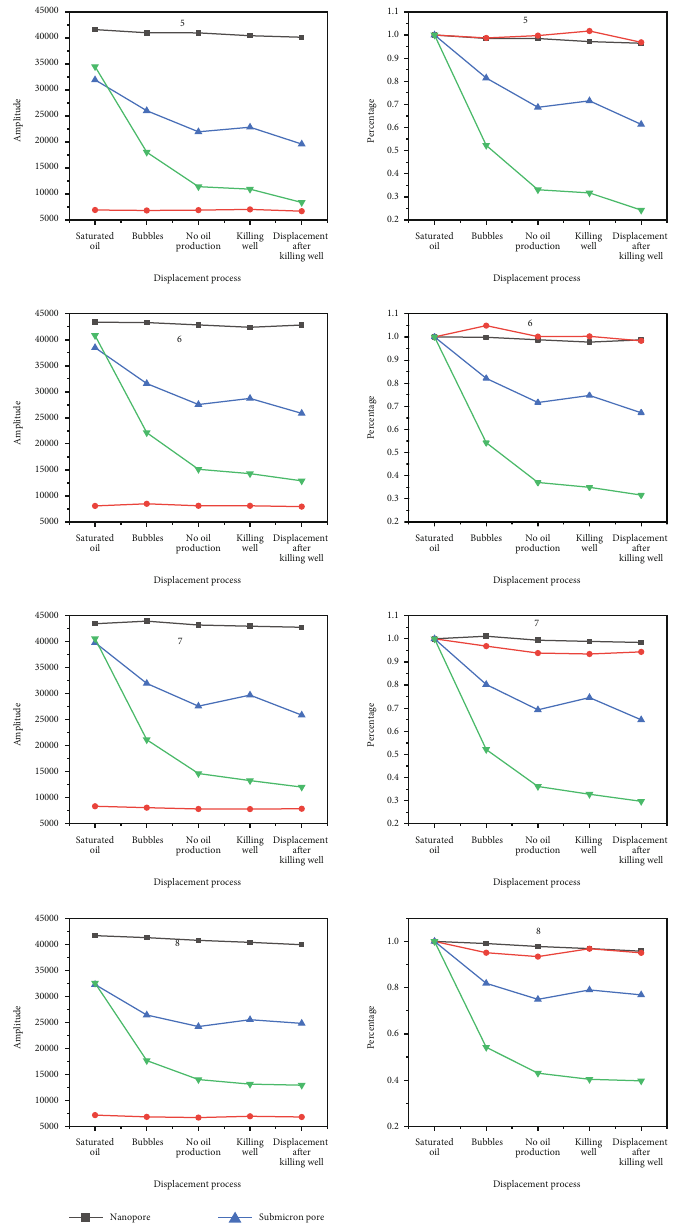
Figure 6: Comparison of the changes in the oil contents of the various types of pores during gas fl